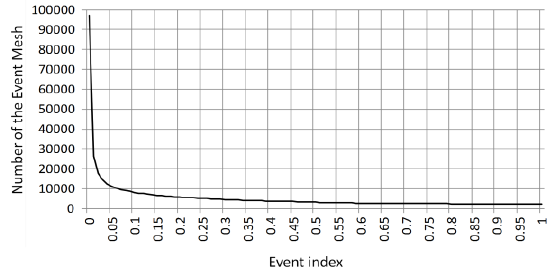
Figure 13. Relationship between the event indexes with the number of the Event Mesh in